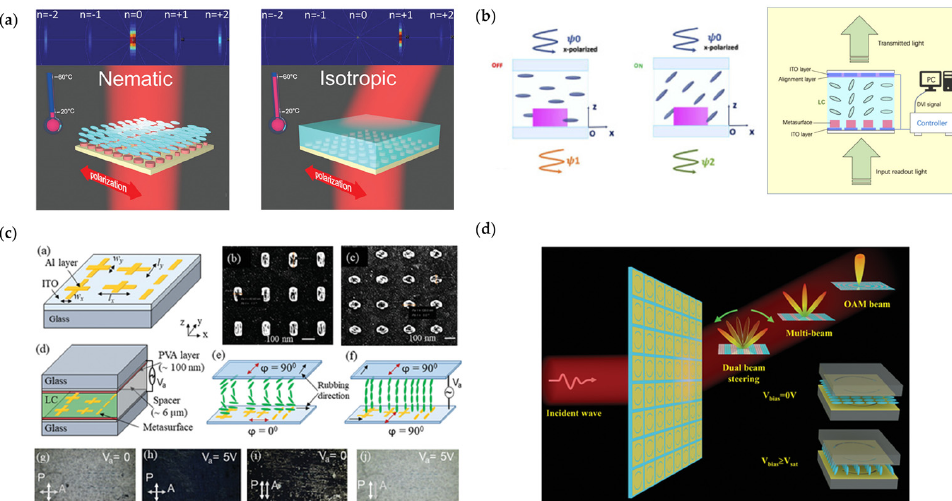
Figure 1. ( a ) Liquid crystal metasurface and its two states while heated. Reprinted with permission from [114] , copyright 2023 American Chemical Society; ( b ) Liquid crystal metasurface excited by electric fields, nano-scale electrodes are used to precisely control the configuration states of the metasurface© 2023 Optica Publishing Group. Users may use, reuse, and build upon the article, or use the article for text or data mining, so long as such uses are for non-commercial purposes and appropriate attribution is maintained. All other rights are reserved. ( c ) LC-based plasmonic metasurface with dynamic color controlling. Reprinted with permission from [129] , copyright © 2000–2023 by John Wiley and Sons, Inc. or related companies. All rights reserved; ( d ) Terahertz LC-based metasurface realizing beam forming. Reprinted with permission from [130], copyright © 2000–2023 by John Wiley and Sons, Inc. or related companies. All rights reserved.